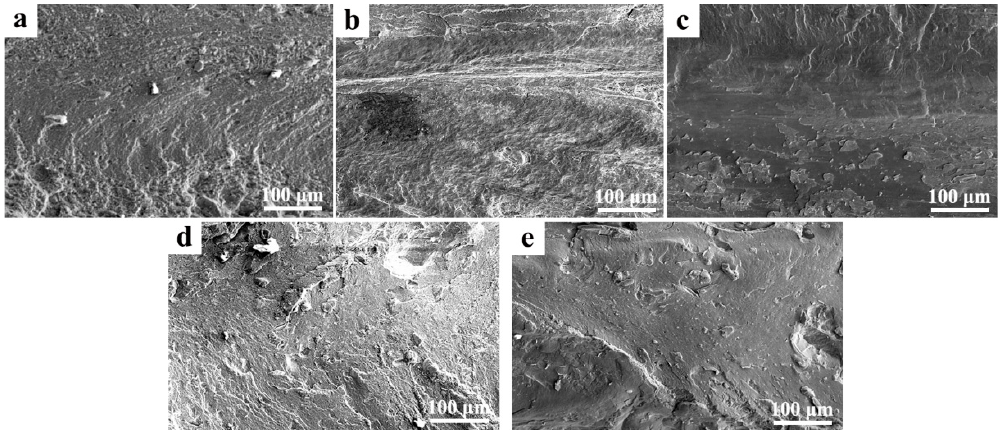
Figure 11. The fracture model images of the ( a ) 450/30, ( b ) 550/30 ( c ) 650/30, ( d ) 550/15, and ( e ) 550/60 samples.